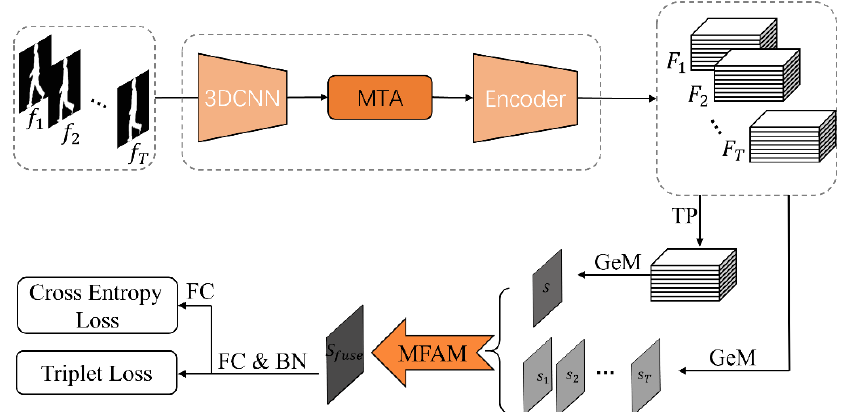
Figure 2. Overview of the gait recognition framework. The Multi-scale Temporal Aggregation (MTA) module extracts contextual information at different temporal scales. The Metric-based Frame Attention Mechanism (MFAM) is employed to highlight key frames in sequences. The TP and GeM represent the Temporal Pooling and Generalized-Mean pooling, respectively.